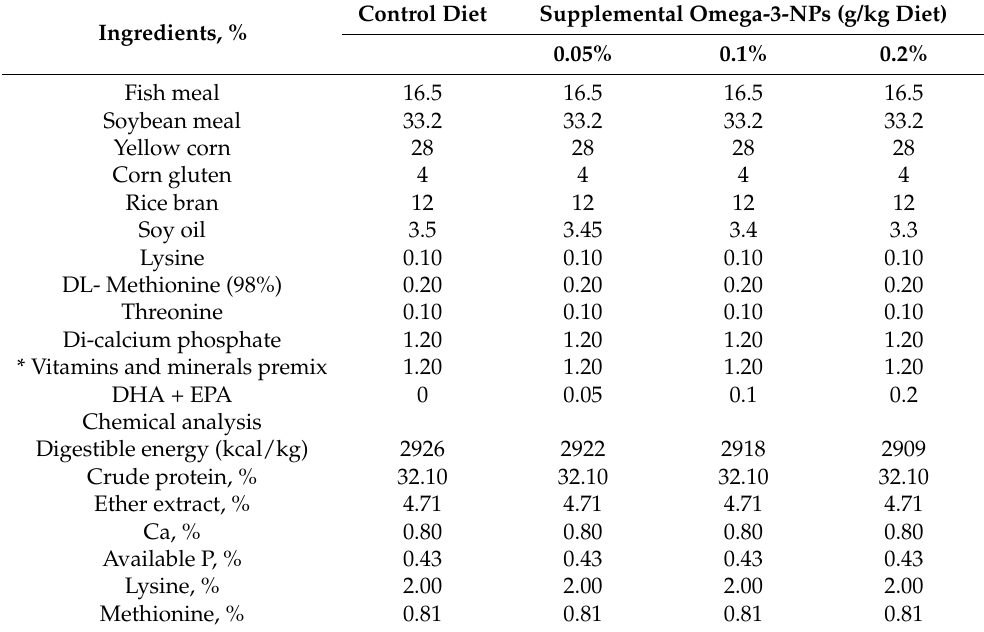
Table 1. Ingredients and chemical composition of the basal diet. Ingredients,